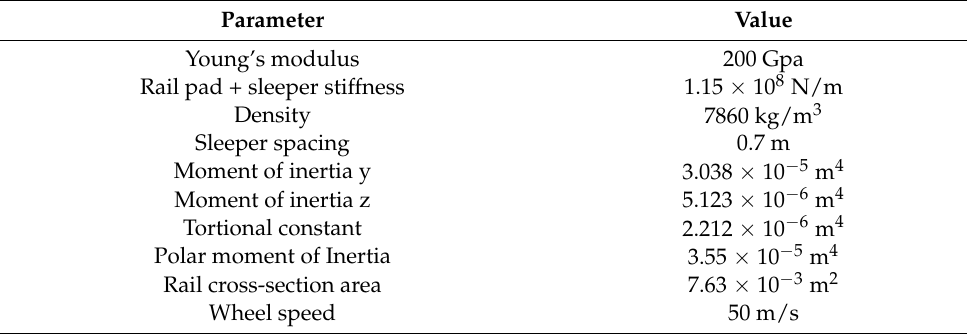
Table 2. Principal parameters of the rail model (data from [18,29]).